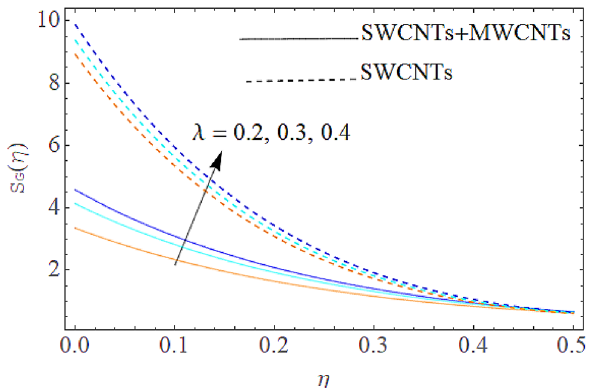
Figure 13. Outcome of (cid:31) on S G .